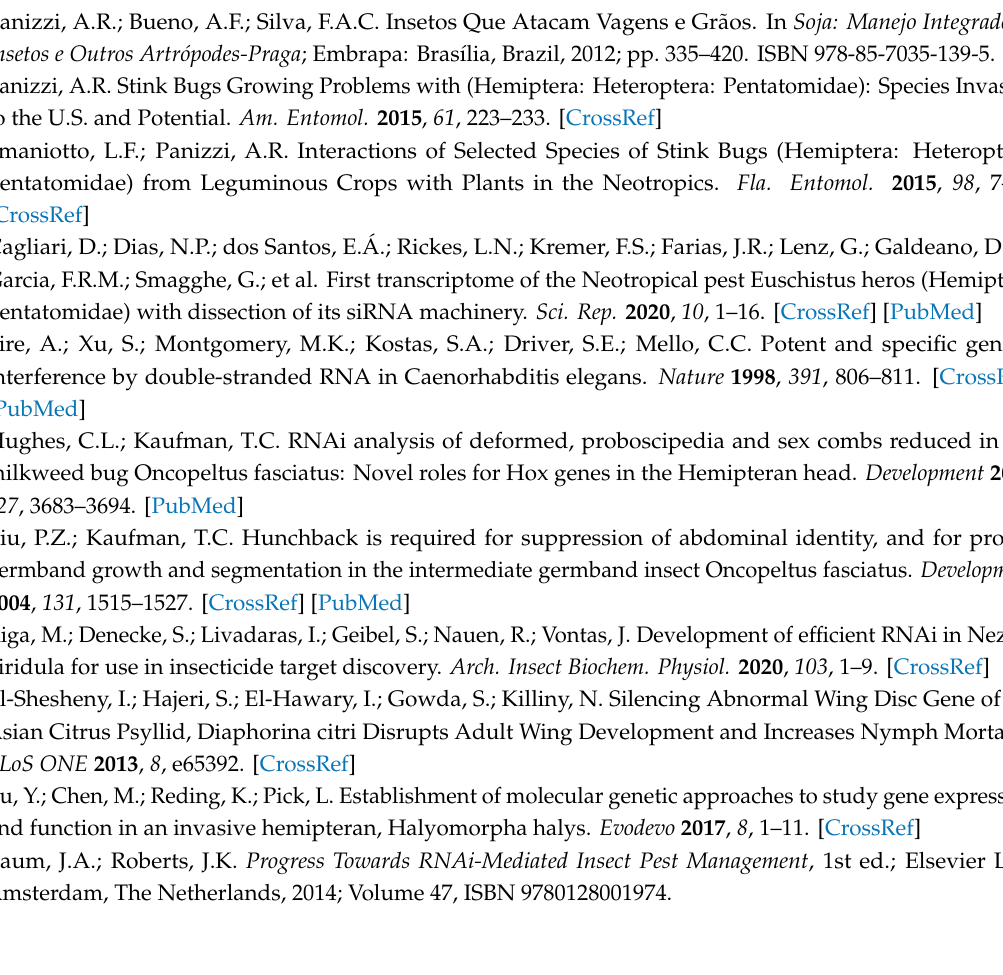
Figure S1: Phylogenetic tree for abnormal wing disc , tyrosine hydroxylase and yellow in E. heros in selected insect species. The protein sequences of the candidate genes from the neotropical stink bug Euschistus heros were aligned using MUCSLE with those of their homologs from other species. The phylogenetic tree was built using maximum likelihood in the software MEGA7 with default settings [24], Figure S2: Expression profile of abnormal wing disc ( awd ), tyrosine hydroxylase ( th ) and yellow ( yel ) in di ff erent life stages of E. heros . (a) Relative gene expression of a wd . (b) Relative gene expression of th . (c) Relative gene expression of yel . Values are based on three biological samples and expressed as means in every treatment. The bars with di ff erent letters denote significant di ff erences ( p < 0.05) according to a Dunn’s test. Confidence bars are shown for ± SEM, Figure S3: Euschistus heros with extremely shortened wings due to treatment with dsRNA targeting the abnormal wing disc ( awd ), Figure S4: Euschistus heros 1st-instar nymphs that hatched from eggs microinjected with yel -sgRNA (300 ng / µ L) and Cas9 protein (300 ng / µ L). Yel -Nymph0, 1 and 3 were sequenced to check for mutation in yel . Yel -Nymph2, 4 and 5 were kept to observe development but they died within 4 days after emergence from the eggs, File S1: Sequences of isoforms of the yellow gene in E. heros and selected region for guide RNA design, Table S1: Euschistus heros samples from di ff erent developmental stages used for stage-specific gene expression analysis, Table S2: Primers used in this study, amplicon size and respective e ffi cacy